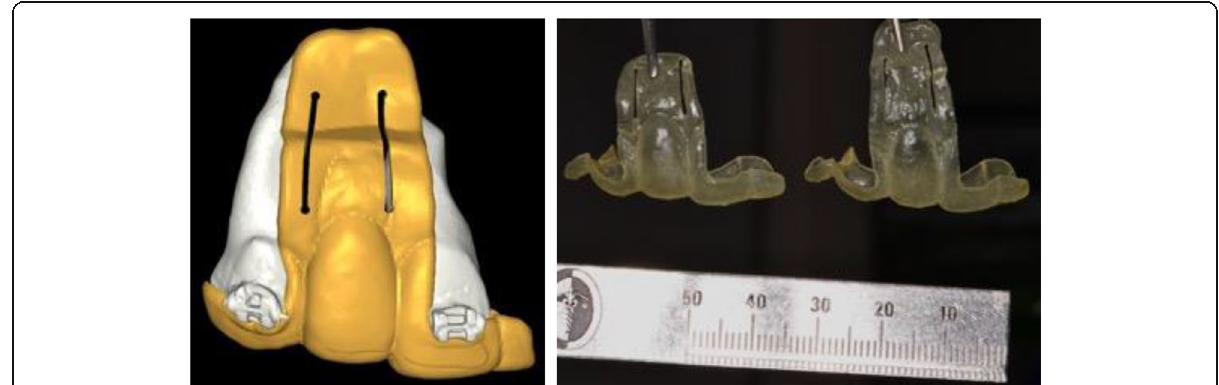
Fig. 3 Surgical guide for segmentary